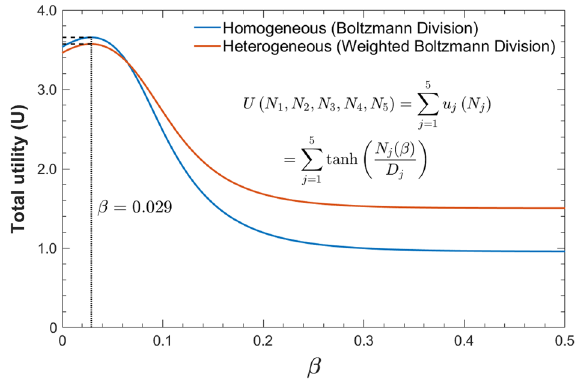
Figure 2. Total utility (U) for the homogeneous and heterogeneous Boltzmann divisions as a function of β . The homogeneous (blue) and heterogeneous (red) cases show maximum at β ≈ 0.029, and then the utilities gradually decrease.